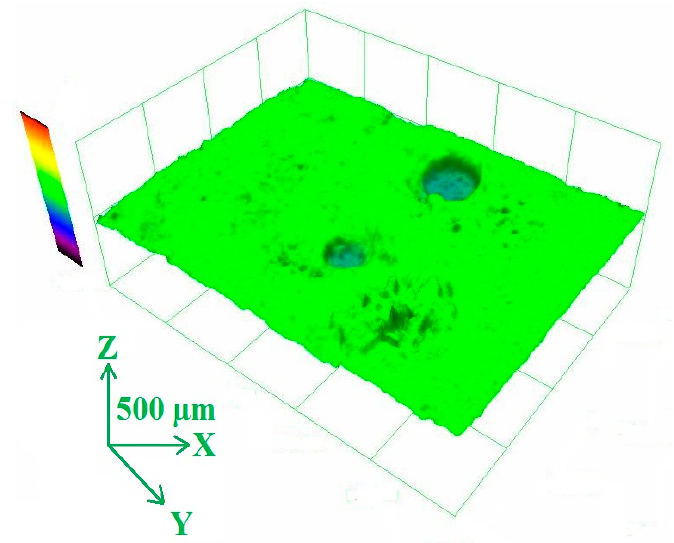
Figure 13. 3D depth projection of the porous structure of UHPC sample after exposure to 200 °C.